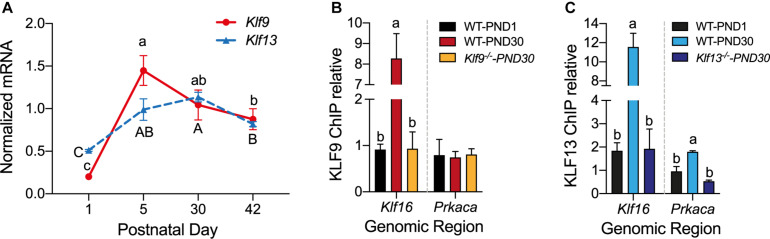
The mRNA levels for Klf9 and Klf13 increase, and KLF13, but not KLF9, associates in chromatin at the promoter region of Prkaca during postnatal development of the hippocampus. (A) Changes in Klf9 and Klf13 mRNA levels in mouse hippocampus during postnatal development. We collected the hippocampal region from mice at postnatal day (PND) 1, 15, 30, and 42, and we quantified Klf9 and Klf13 mRNAs by RT-qPCR. We normalized the Klf mRNA levels to the geometric means of the mRNA levels of the reference genes Gadph and Ppia. The mean mRNA levels of both Klf genes peaked at PND15, remained elevated at PND30, and declined at PND42. Points represent the mean ± SEM [Klf9: F(3,26) = 55.84, p < 0.0001; Klf13: F(3,12) = 24.99, p < 0.0001; one-way ANOVA followed by Tukey’s post hoc test; n = 4/treatment]. Means with the same letter are not significantly different. (B,C) We analyzed KLF9 and KLF13 occupancy in chromatin at the promoter regions of the Klf16 and Prkaca genes in wild type (WT) mouse hippocampus at PND1 and PND30, and PND30 Klf9–/– and Klf13–/– mice using ChIP qPCR. We normalized the KLF9 and KLF13 ChIP values to the signal obtained with IgGs purified from normal goat (KLF9) or normal rabbit (KLF13) serum. Bars represent the mean ± SEM (n = 4/treatment). Means with the same letter within a gene analyzed are not significantly different (p < 0.05; one-way ANOVA followed by Tukey’s post hoc test.). (B) The KLF9 ChIP signal at the Klf16 gene promoter was greater in WT PND30 mice compared to PND1, and also compared to Klf9–/– PND30 mice (which was not different from PND1 WT mice) [F(2,9) = 28.80, p = 0.0001]. The mean KLF9 ChIP signal at the Prkaca gene promoter was at background level (the level of the Klf9–/– PND30 mice) in WT PND1 and PND30 mice. (C) The KLF13 ChIP signal at the Klf16 gene promoter was greater in WT PND30 mice compared to PND1, and also compared to Klf13–/– PND30 mice [which was not different from WT PND1 mice; F(2,10) = 36.01, p < 0.0001]. The mean KLF13 ChIP signal at the Prkaca gene promoter in WT PND30 mice was greater than the level in WT PND1 and Klf13–/– PND30 mice [F(2,7) = 14.89, p = 0.003].